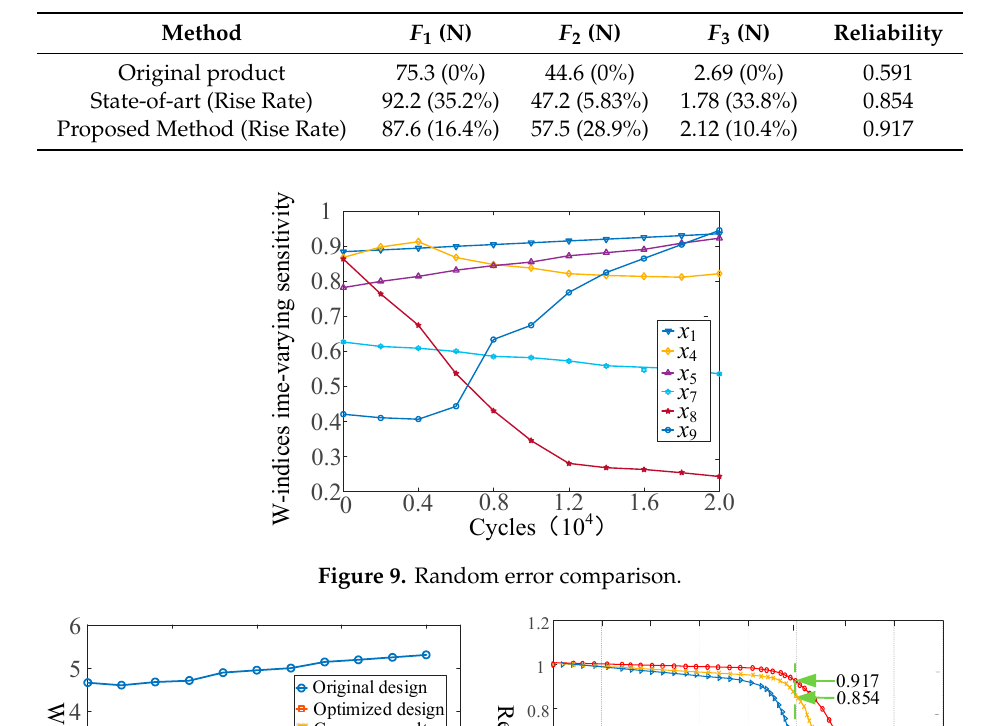
Table 2. Comparison of optimization results.